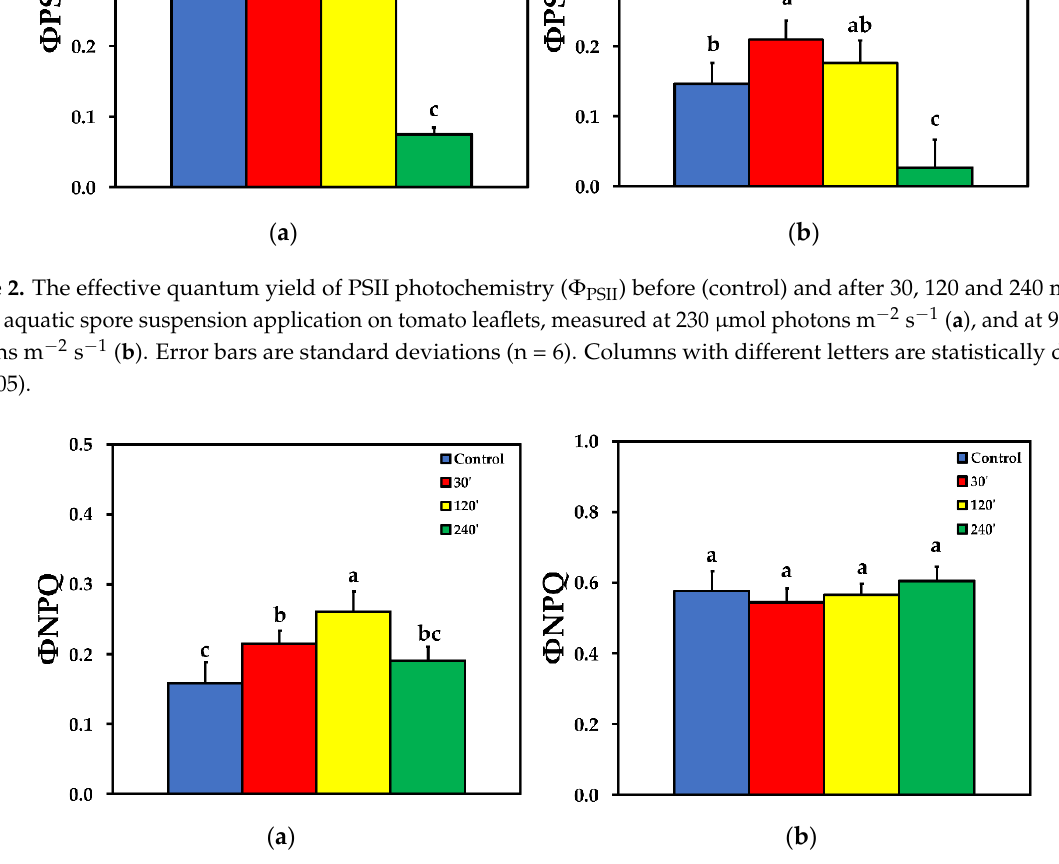
Figure 3. The quantum yield of regulated non-photochemical energy loss in PSII ( Φ NPQ ) before (control) and after 30, 120 and 240 min of B. cinerea aquatic spore suspension application on tomato leaflets, measured at 230 μ mol photons m − 2 s –1 ( a ), and at 900 μ mol photons m − 2 s –1 ( b ). Error bars are standard deviations (n = 6). Columns with different letters are statistically different ( p < 0.05).